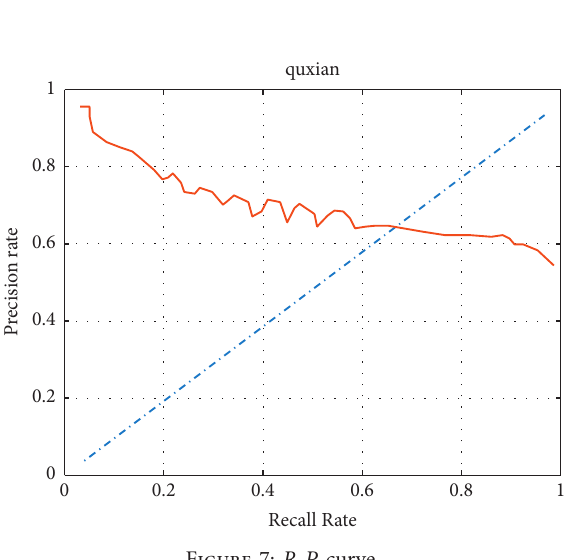
Figure 6: ROC graph.